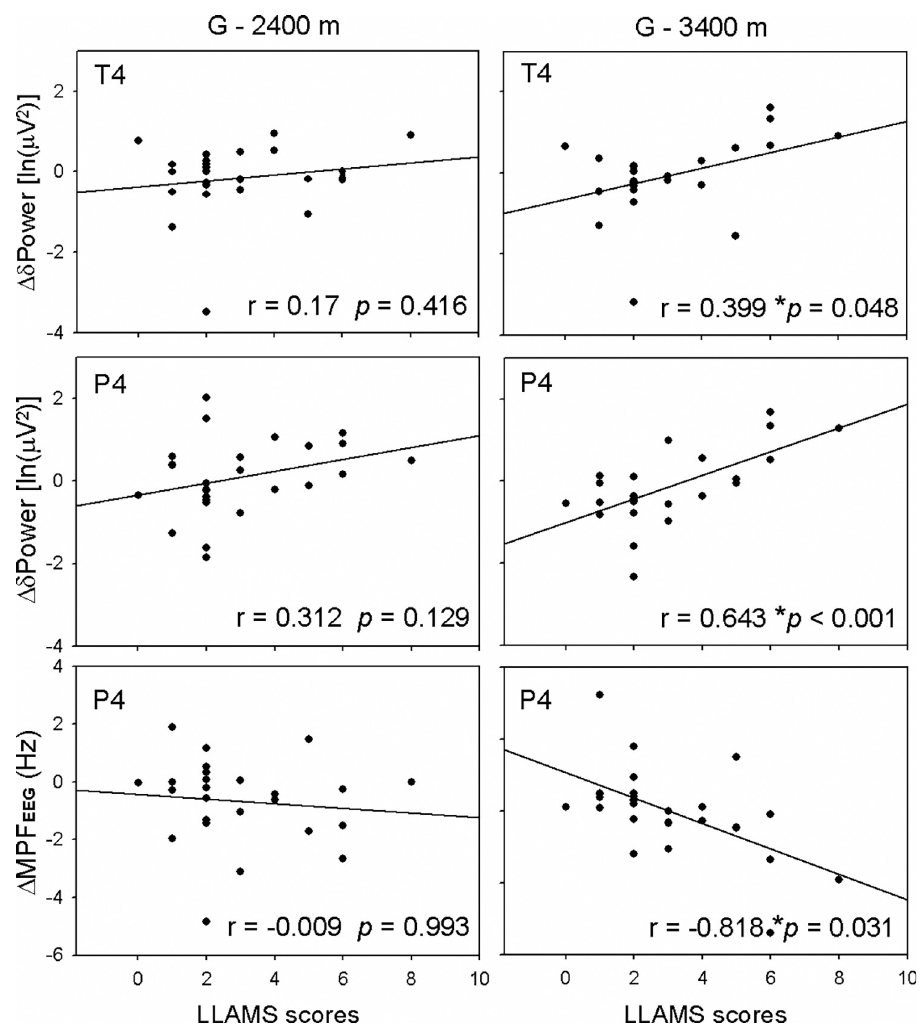
Fig 5. The differences of δ power spectrum at T4 and P4 and of MPF EEG at the P4 electrode from ground to 3,400 m were significantly corrected with LLAMS scores, but not from ground to 2,400 m. Correlation between slow cerebral activity and the severity of LLAMS scores. Significant differences were found using the least significant difference (LSD) as � p < 0.05 by Pearson’s correlation. LLAMS, Lake Louise Acute Mountain Sickness; MPF EEG, mean power frequency of electroencephalography; T4, temporal electrode 4; P4, parietal electrode 4.